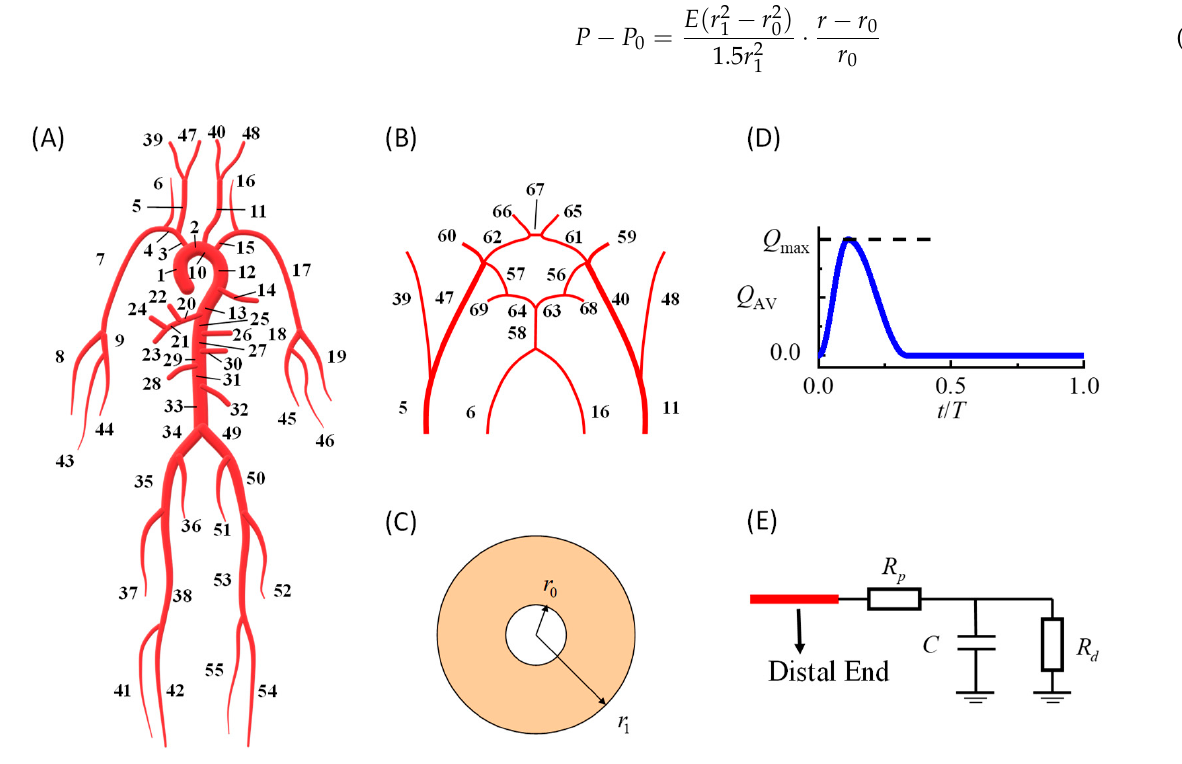
Figure 1. Hemodynamic simulation model of the human cardiovascular system: ( A ) 1D model of the systemic artery tree; ( B ) 1D model of the Willis circle; ( C ) cross-section of the artery model; ( D ) prescribed flow rate curve at the inlet of the ascending aorta; ( E ) peripheral vessel model at the outlets of the artery networks; 1D, one-dimensional.